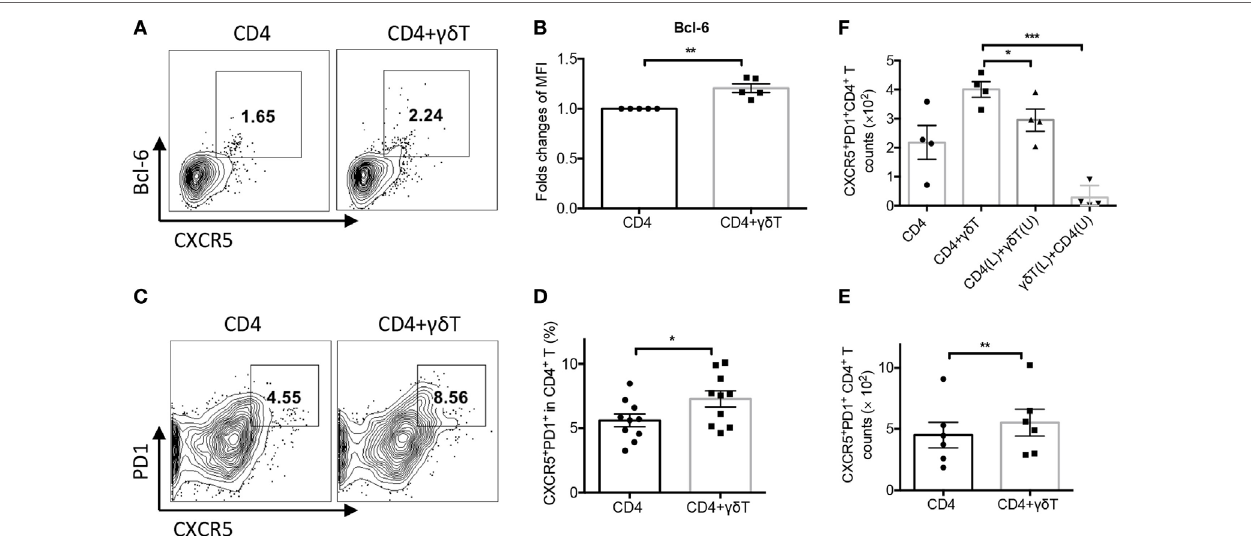
FigUre 2 | V γ 9V δ 2-T cells promoted CD4 + T follicular helper (Tfh) cells differentiation. Naïve CD4 T cells were cultured with UV-H9N2 virus-pulsed dendritic cells for 4–5 days, then, the activated CD4 T cells were cultured with CD19 + B cells from same donor with or without V γ 9V δ 2-T cells for another 7–10 days. (a) Percentage of CXCR5 + Bcl-6 + CD4 + Tfh cells was detected on day 5 by flow cytometry. (B) Bcl-6 mean fluorescence intensity (MFI) fold changes were detected on day 5 by flow cytometry. (c–e) Number and percentage of CXCR5 + PD1 + CD4 + Tfh cells were detected on day 5. (F) CD4 + T cells and V γ 9V δ 2-T cells were put in upper (U) or lower (L) chamber of transwell system in indicated group. Number of CXCR5 + PD1 + CD4 + Tfh cells were detected. FACS data represent four to nine independent experiments. Each dot means one donor. The data shown are the mean ± SEM. * p < 0.05; ** p < 0.01; *** p <